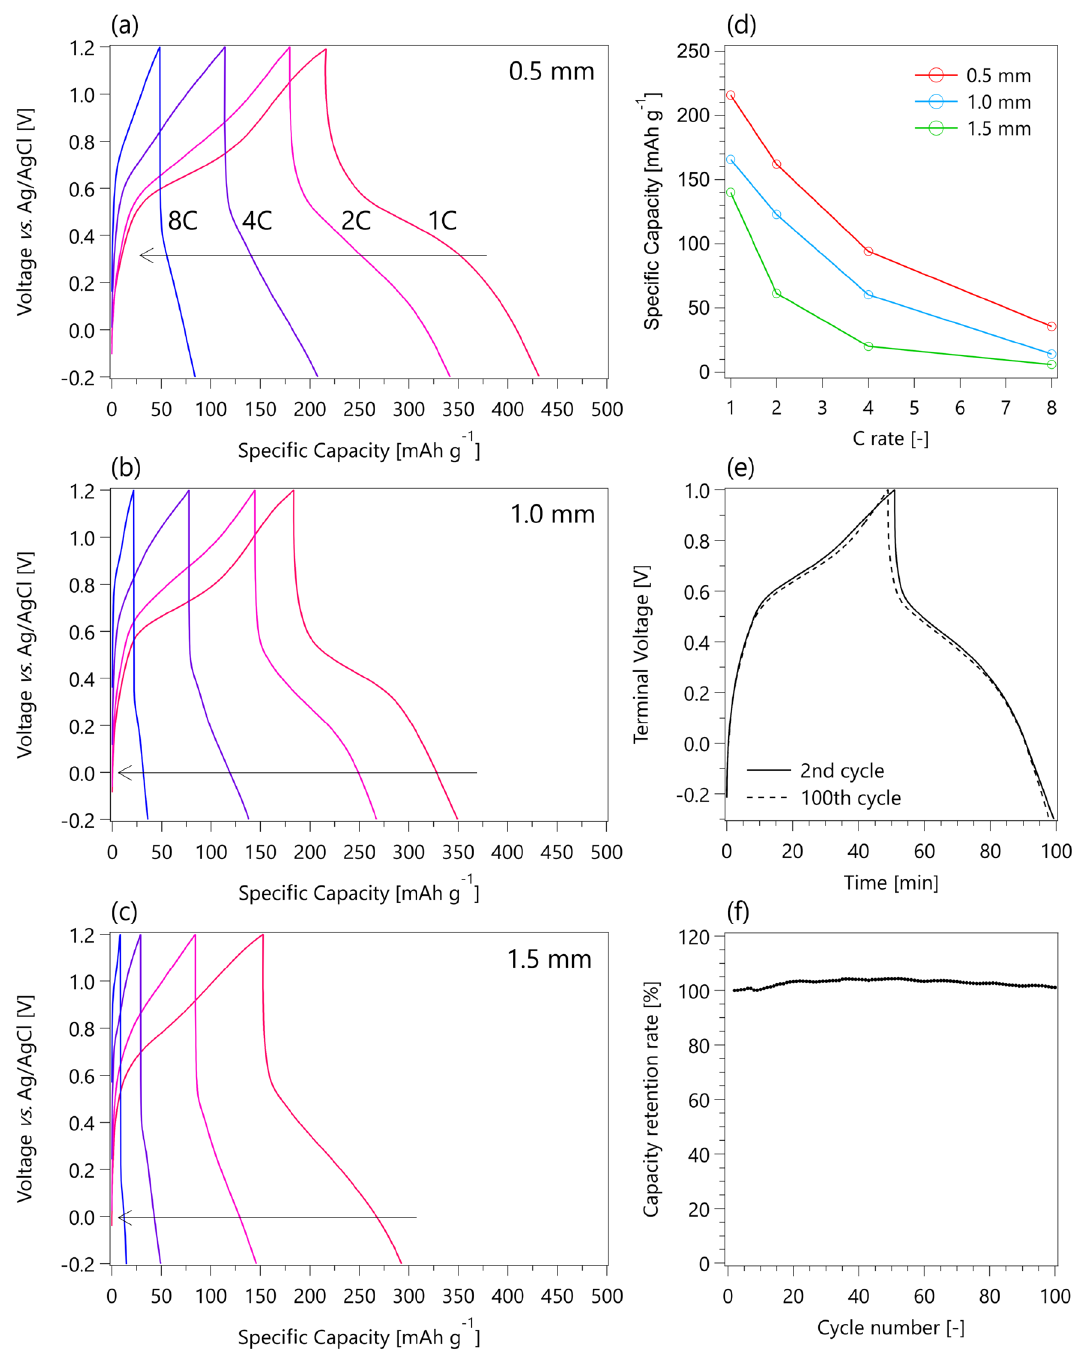
Figure 2. ( a – c ) Rate performances of 10 cm × 10 cm × 0.52 cm single cells with different electrode thicknesses (0.5, 1.0 and 1.5 mm). ( d ) The specific capacities of the three types of single cells (0.5, 1.0 and 1.5 mm) at 1, 2, 4, and 8 C rates. ( e ) Charge and discharge profiles of a single cell at a 1 C rate with 1.0 mm thickness at the 2nd and the 100th cycles. ( f ) The capacity retention rate of a single cell at a 1 C rate for 100